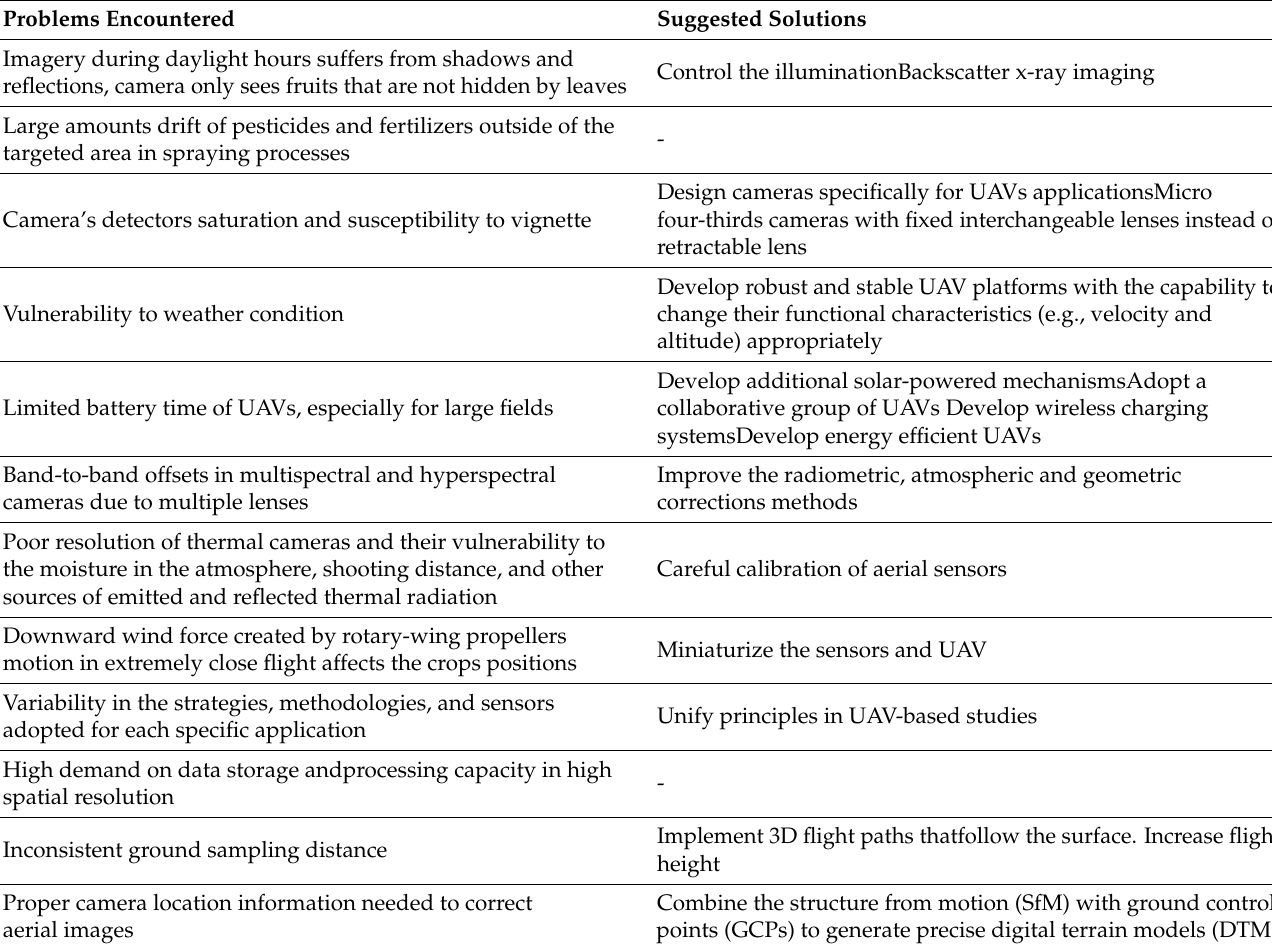
Table 10. Unresolved challenges of UAV flights and some suggestions to address